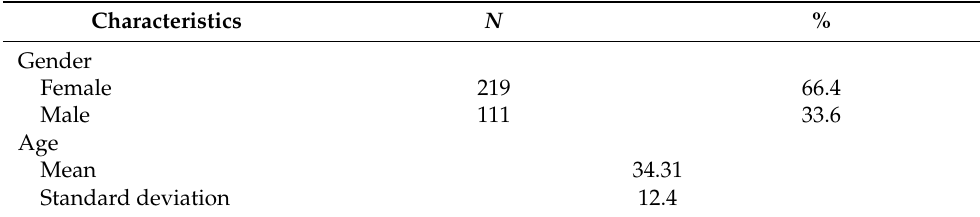
Table 1. Demographic Characteristics of the